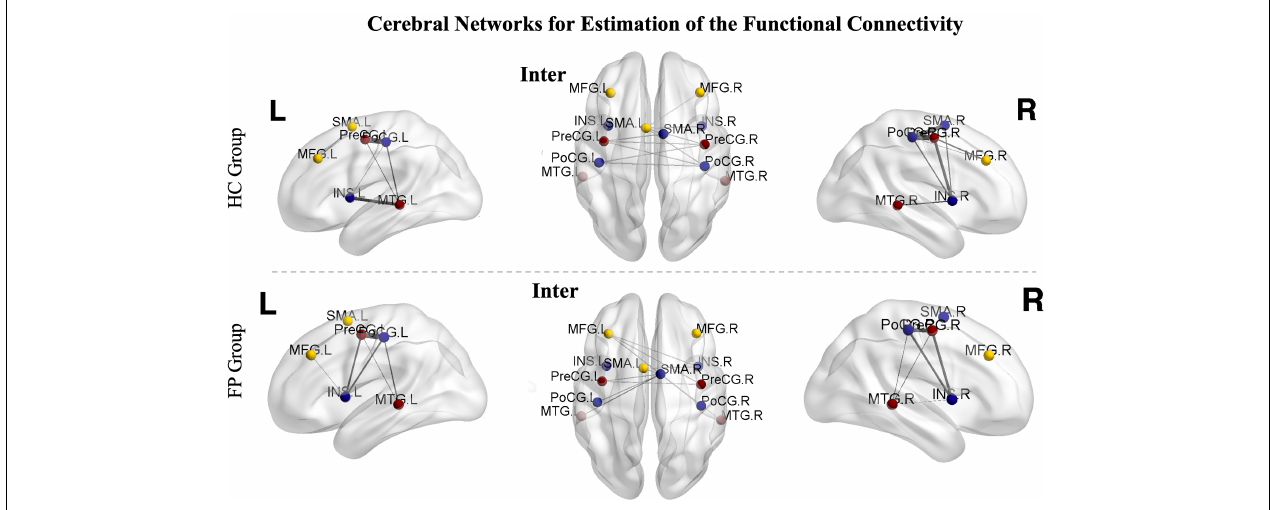
FIGURE 4 | Cerebral networks for the estimation of functional connectivity. The identified areas constitute the right hemispheric, left hemispheric, and interhemispheric networks. The nodes represent the peak activated locations, and the edges represent the strengths of connectivity. The images from controls are shown in the upper part of the figure, while images from the patients are shown in the lower part. Sparsity was set to 50%. PoCG, postcentral gyrus; PreCG, precentral gyrus; SMA, supplementary motor area; MFG, middle frontal gyrus; MTG, middle temporal gyrus; INS, insula; R, right; L, left; FP, facial paralysis patients; HC, healthy controls.